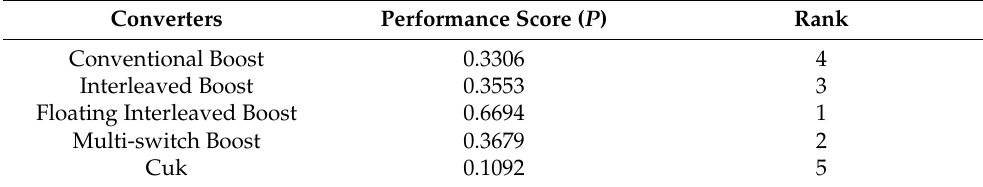
Table 3. The determined performance scores and ranks for the candidates (first scenario).